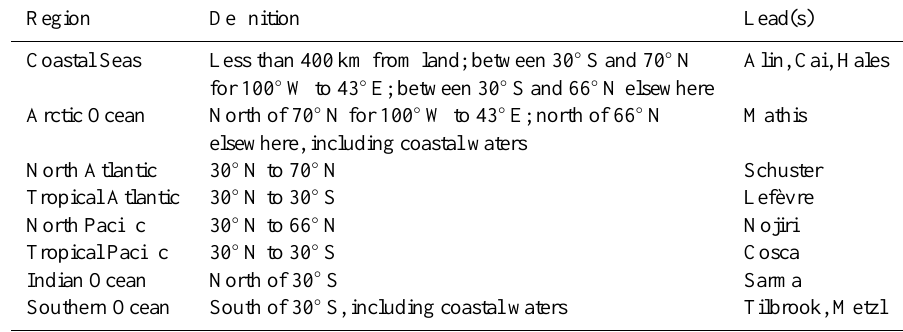
Table 5. Regions and regional group leads in SOCAT version 2 (Fig. 5).